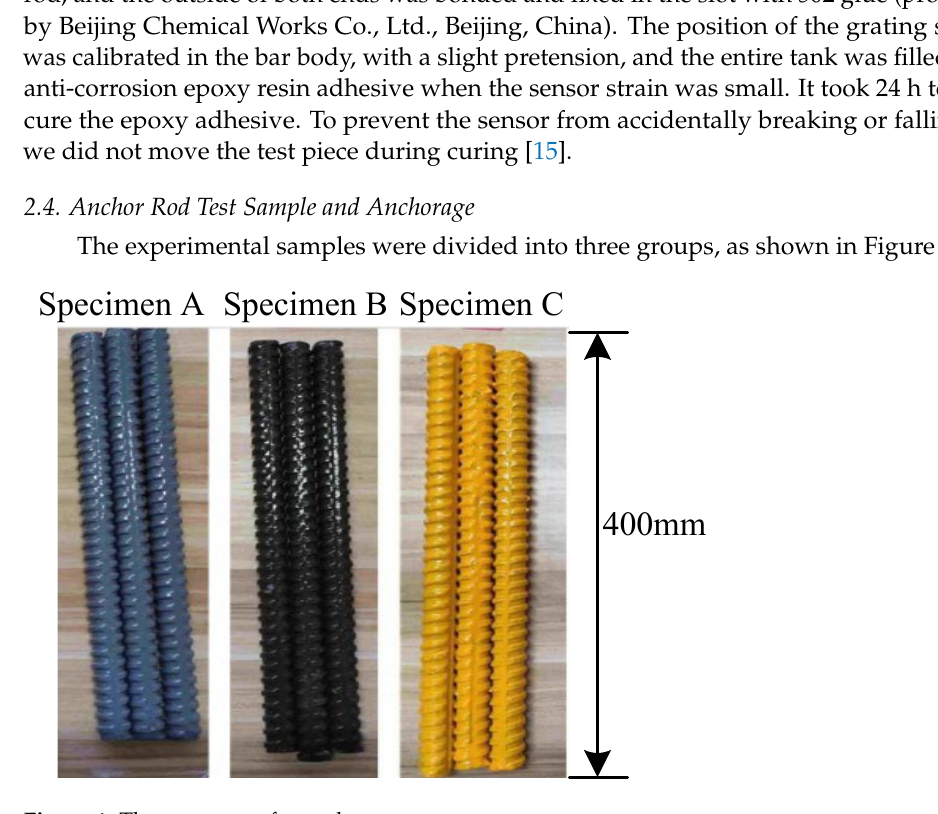
Figure 1. Three groups of samples.